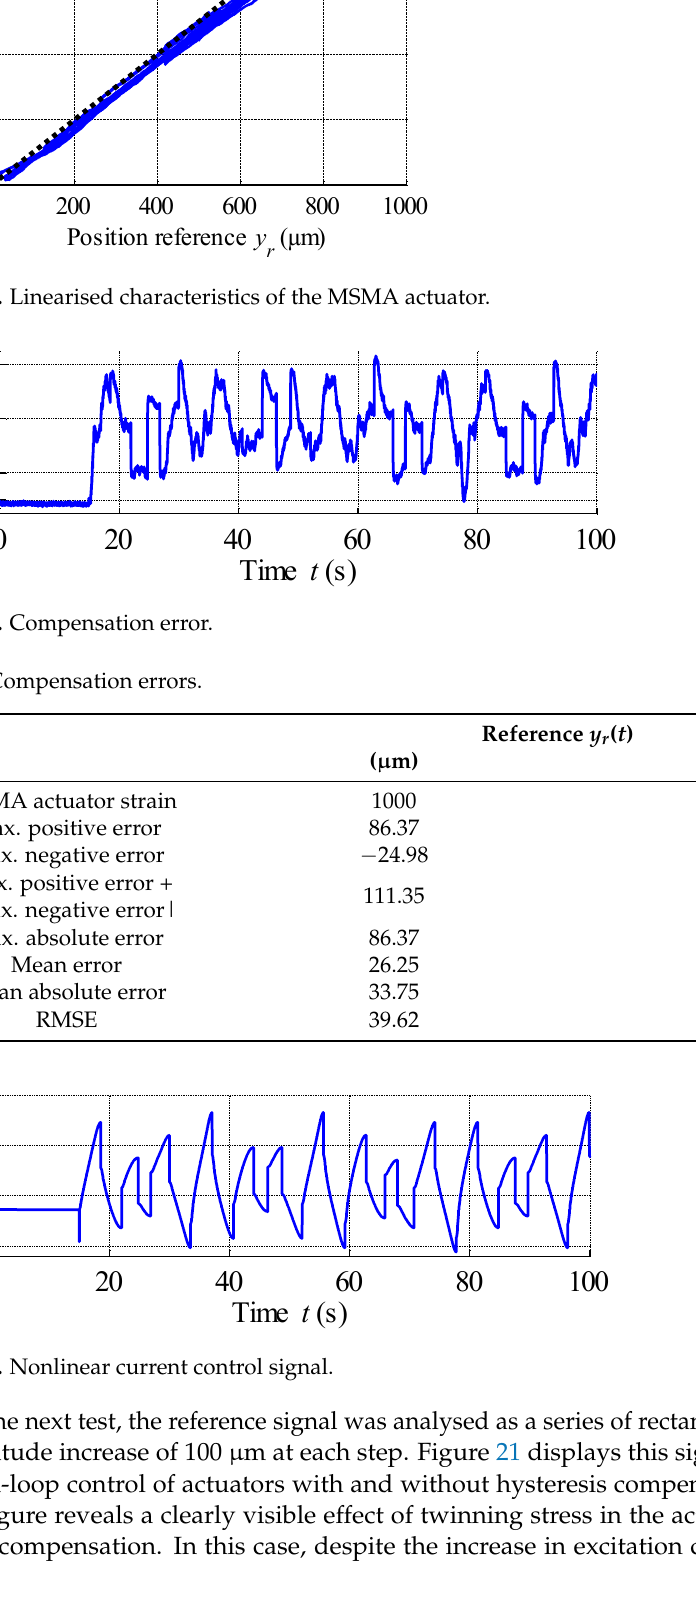
Figure 17. Open-loop control with compensator placed in series in the control loop.